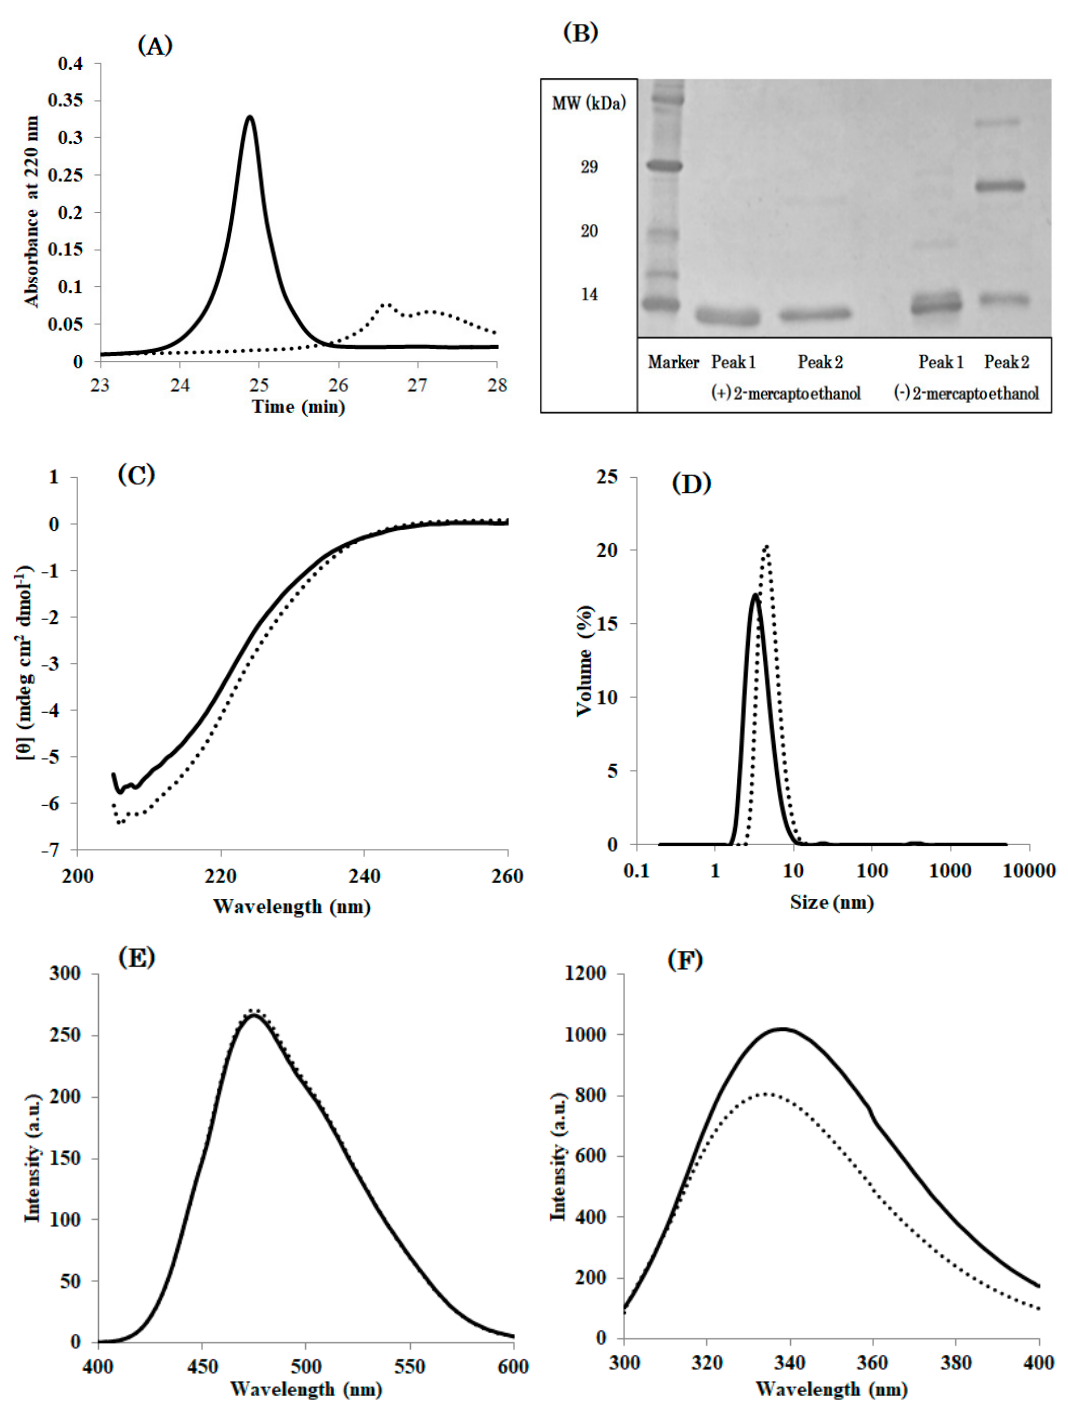
Figure 3. Further examination of Peak 1 (solid line) and Peak 2 (dotted line) obtained at RP-HPLC of DEN4 ED3-3rd ppt. ( A ) RP-HPLC chromatograms of two peaks. ( B ) SDS-PAGE result of two peaks in the presence or absence of 2-mercatptoethanol. ( C ) CD spectra at pH 5 and 20 ◦ C. ( D ) Size-volume graphs measured by DLS at pH 5 and 20 ◦ C. ( E ): ANS fluorescence spectra at pH 5.0 and 20 ◦ C. ( F ) Tryptophan fluorescence spectra at pH 5.0 and 20 ◦C.